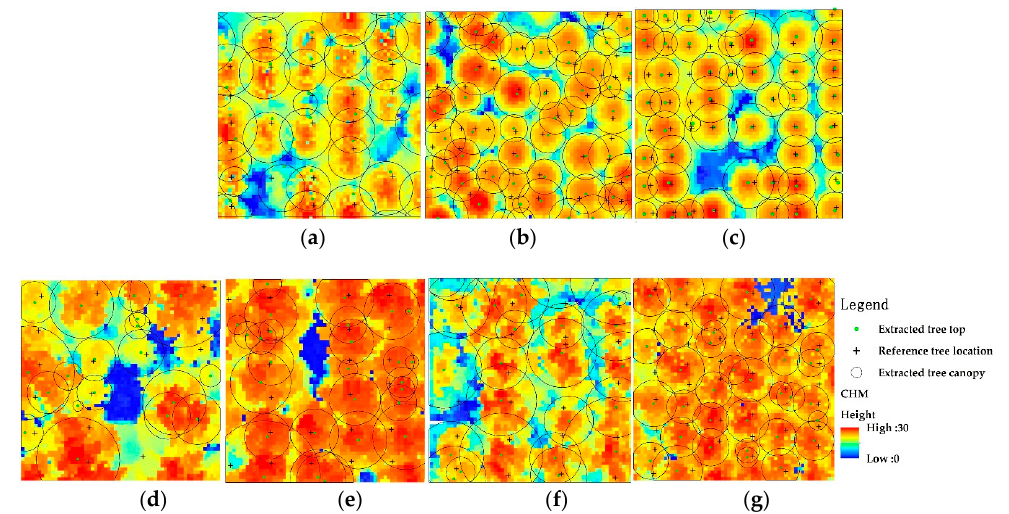
Figure 8. The segmentation results of marker-controlled watershed segmentation for seven plots: ( a ) Plot 1, ( b ) Plot 2, ( c ) Plot 3, ( d ) Plot 4, ( e ) Plot 5, ( f ) Plot 6, and ( g ) Plot 7.